Question: Provide a one-line summary of what is displayed.
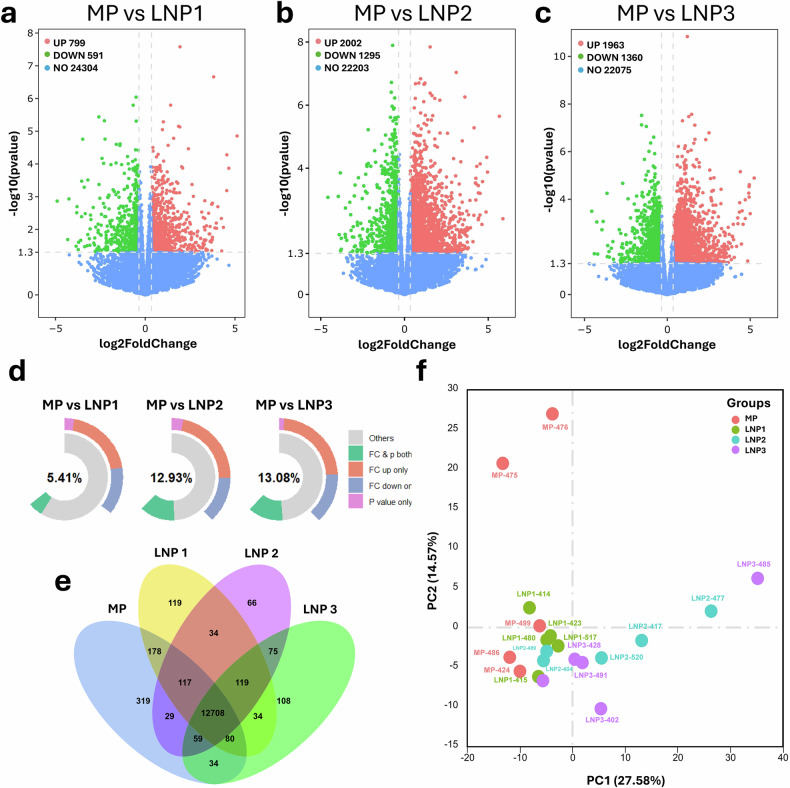
Answer: Transcriptomic analysis of the effects of PUFA-enriched LNPs in MP-treated mice (volcano plots, donut charts, Venn diagram, and PCA), revealing the large-scale genetic reprogramming underlying LNP therapeutic outcomes. Gene expression correlation and differential gene expression analysis of ( a – c ) volcano plots for MP vs LNP1, MP vs LNP2, and MP vs LNP3. Up- (red) or downregulated (green) genes are indicated by a log2FC ≥ 0.35 and p < 0.05. d Donut charts summarizing, for each comparison, the fraction of genes that passed both criteria (center percentage). The ring segments indicate the categories (FC & p both, FC only, p only, and others that do not pass the threshold). e Venn diagram showing the overlap of DEGs among the MP, LNP1, LNP2, and LNP3 comparisons. f PCA of variance-stabilized expression values. The samples were clustered by group, with PC1 (27.6%) and PC2 (14.6%). n = 5 per group; RNA samples were derived from hippocampal tissue